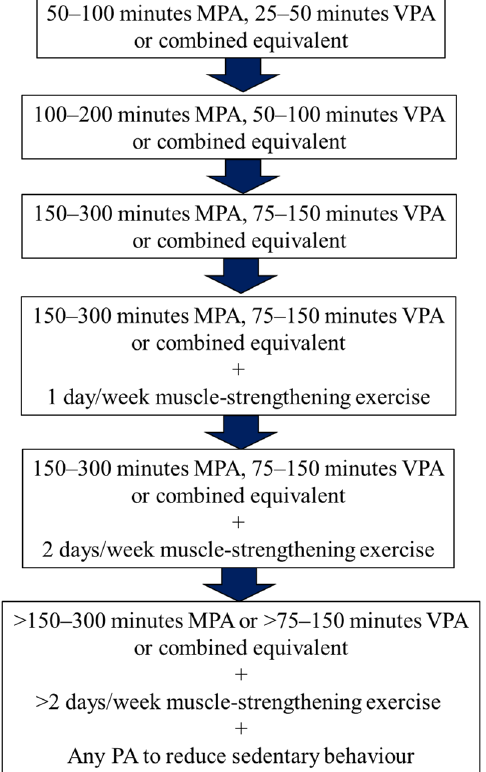
Figure 2. Chart demonstrating an example of intermediary steps that can be taken to achieve optimal physical activity goals, as defined by the World Health Organization.